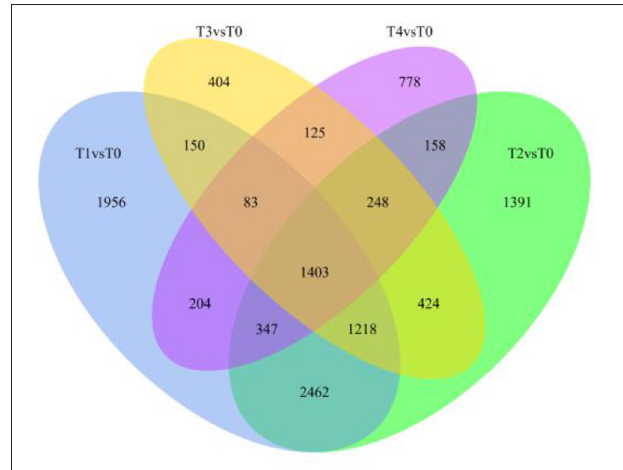
FIGURE 1 | Differential gene Venn map. The sum of the numbers in the Venn diagram represents the total number of differentially expressed genes (DEGs). The overlapping indicates the number of DEGs common in the combinations. T0, T1, T2, T3, and T4 stand for the Fusarium oxysporum -treated Pdpap by 0, 6, 12, 24, and 48h, respectively. The numbers 1, 2, 3, and 4 after the treatment name stands for four biological repetitions of the same treatment